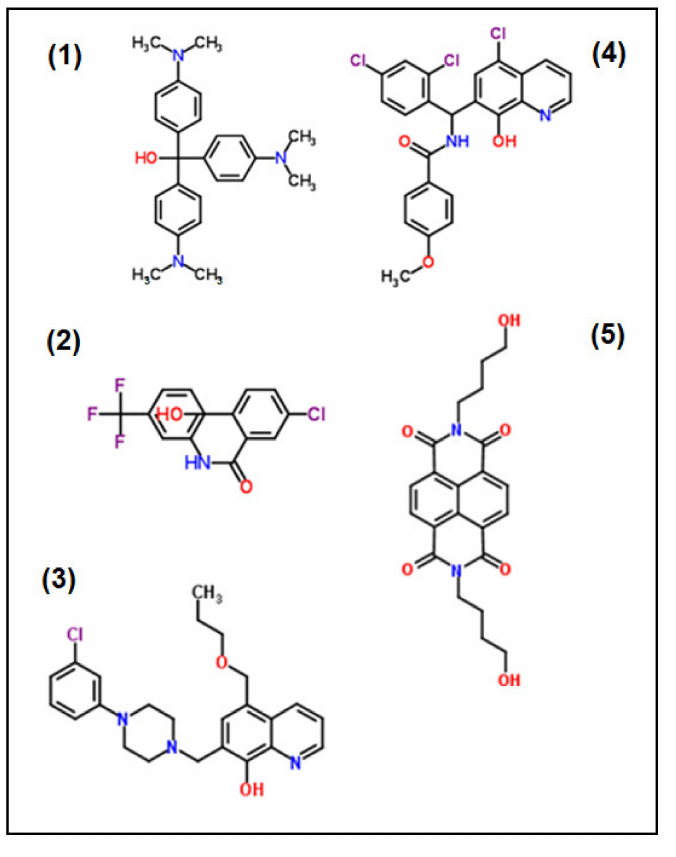
Figure 3. Structures of the five MMV Malaria Box compounds inhibiting N. caninum proliferation in vitro with IC 50 values below 200